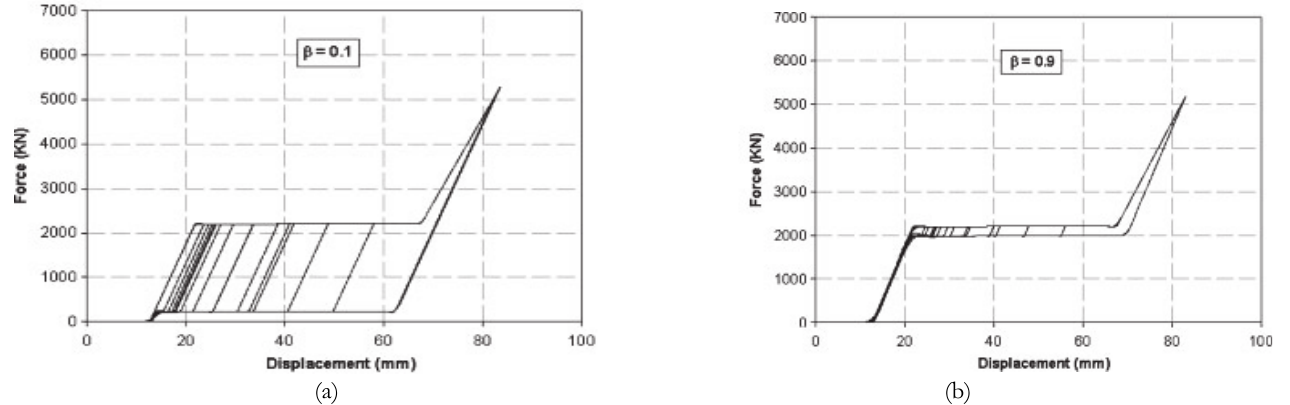
Figure 5: Load–deformation relationships for the two SMA restrainers with different hysteresis height, (a) Thick hysteresis [17]; (b) Narrow hysteresis